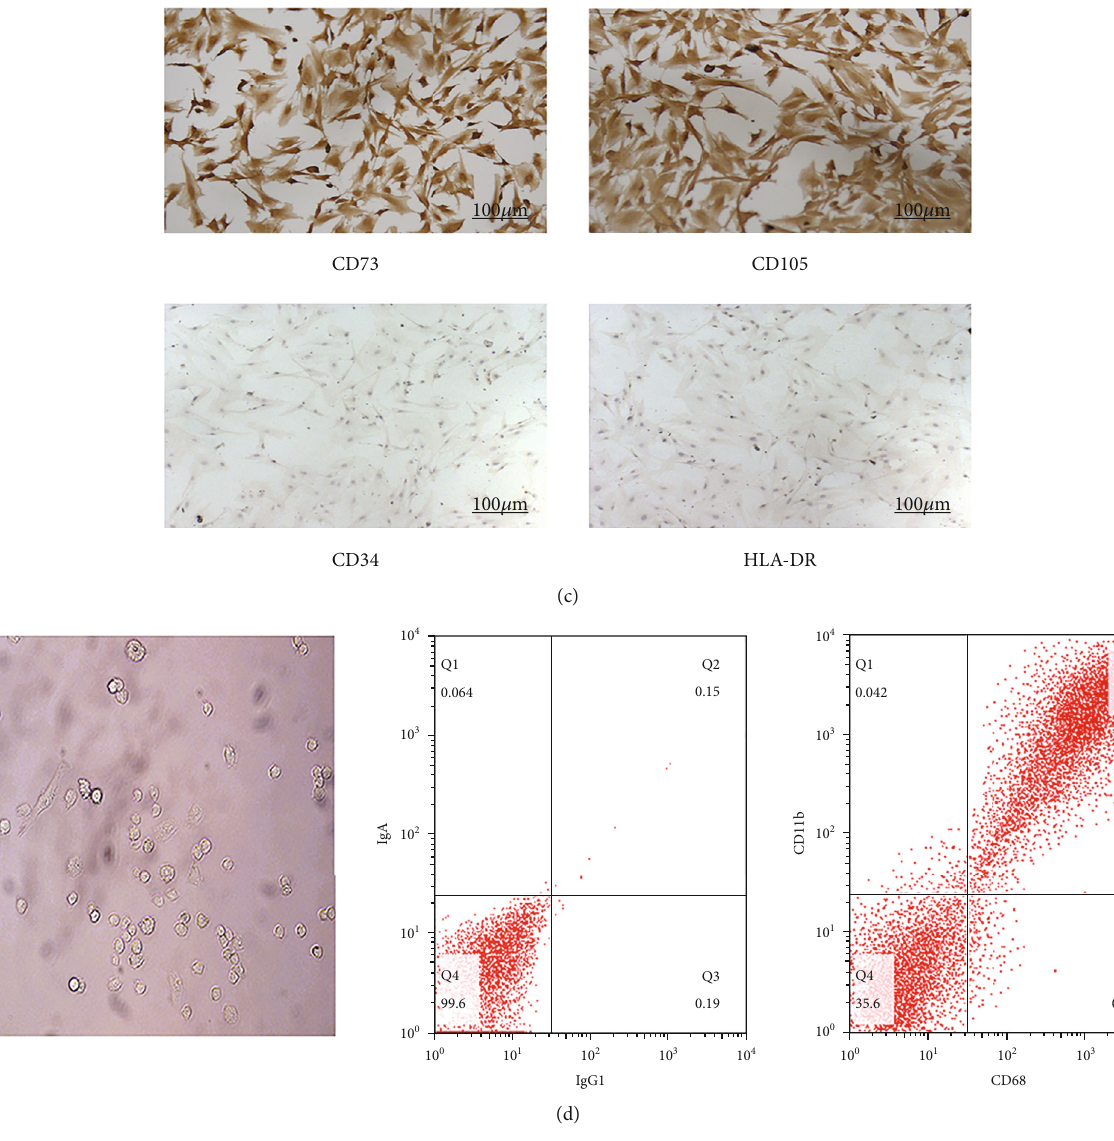
Figure 1: Characterization of PBMSC morphology, multidirectional di ff erentiation potential, and phenotype and of macrophage morphology and phenotype. (a) Growth morphology of PBMSCs cultured for 24h ( × 100). After induction of osteoblasts, chondroblasts, and adipoblasts for 21 days, the di ff erentiation ability of PBMSCs was evaluated using Alizarin Red, Alcian blue, and oil red O staining, respectively. (b) P3 PBMSCs were positive for CD29, CD90, and CD44, but negative for CD45, CD79, and CD11b. (c) Hematoxylin- stained P3 PBMSCs were positive for CD73 and CD105 expression, but negative for CD34 and HLA-DR expression. (d) Left: morphology of M0 macrophages after 10 days of culture ( × 100). Right: expression of CD11b, CD68, IgA, and IgG2b in M0 macrophages. CD: cluster of di ff erentiation; PBMSCs: peripheral blood-derived mesenchymal stem